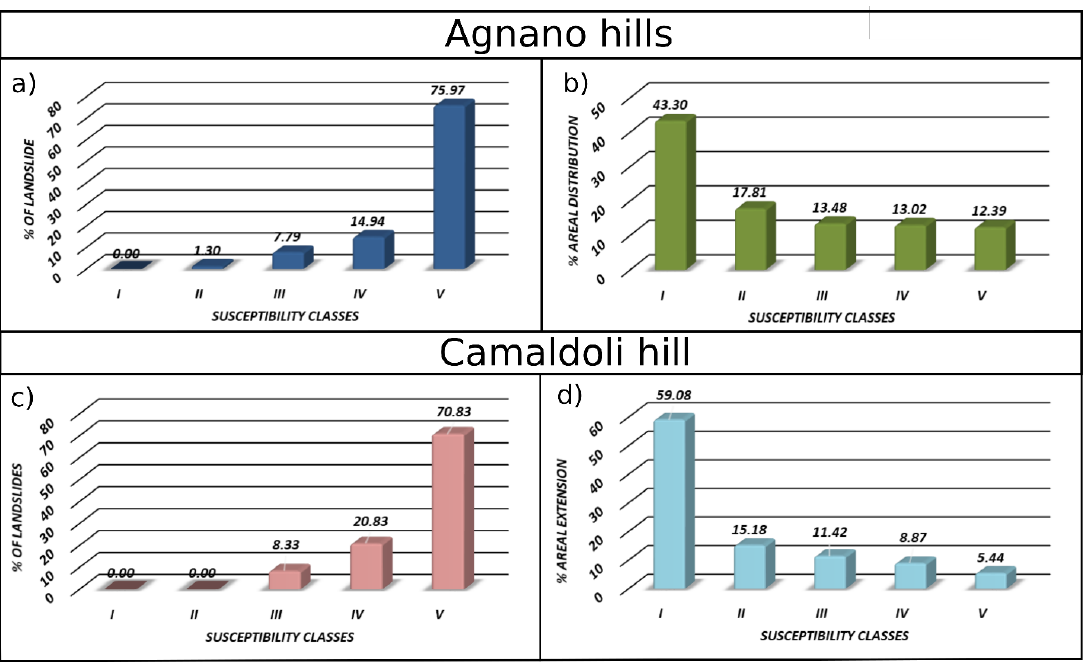
Table 6. AUC/ROC and TSS scores for the ensemble models used.